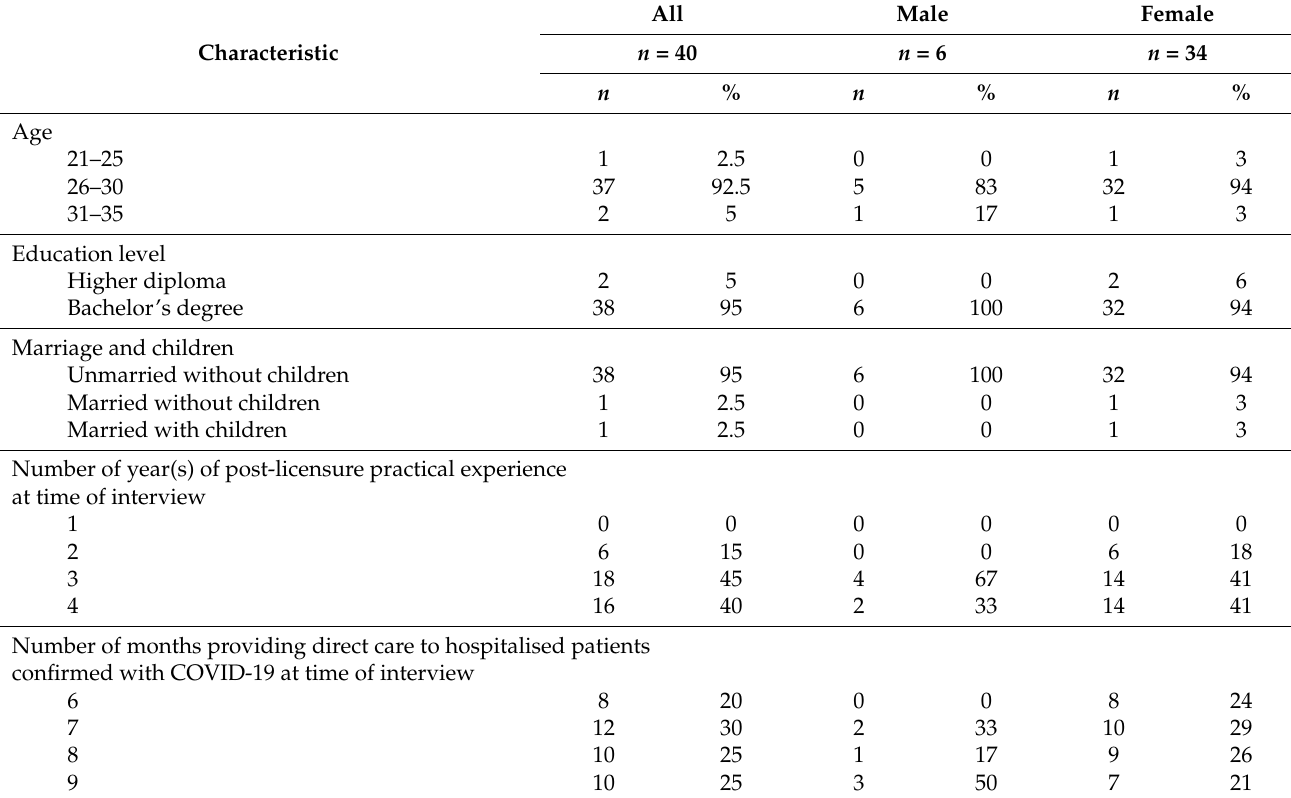
Table 1. Participant